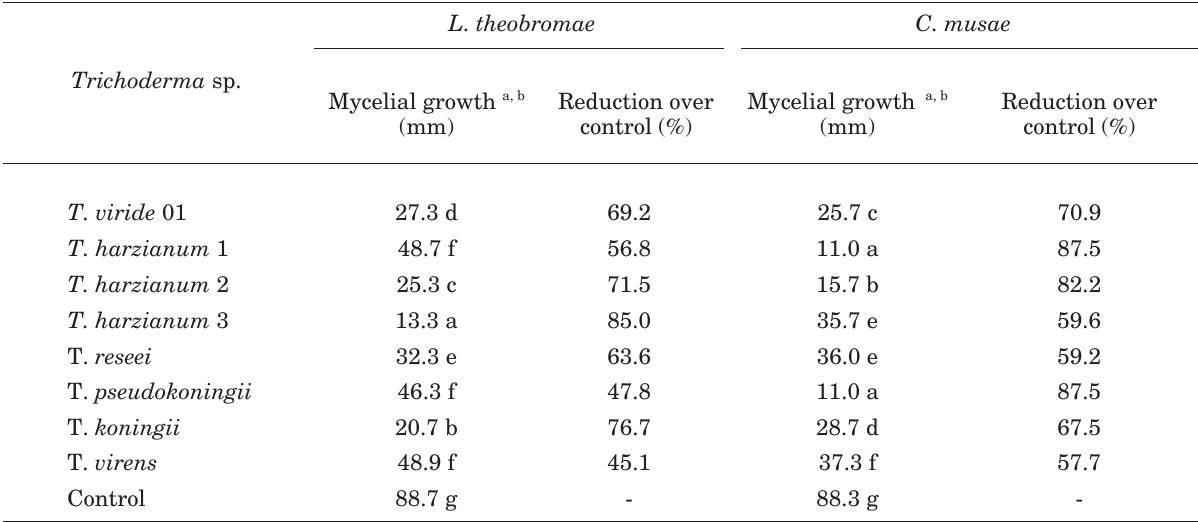
2. Mean mycelium growth of Lasiodiplodia theobromae and Colletotrichum musae and proportional reductions (compared with controls) for different introduced Trichoderma isolates tested in